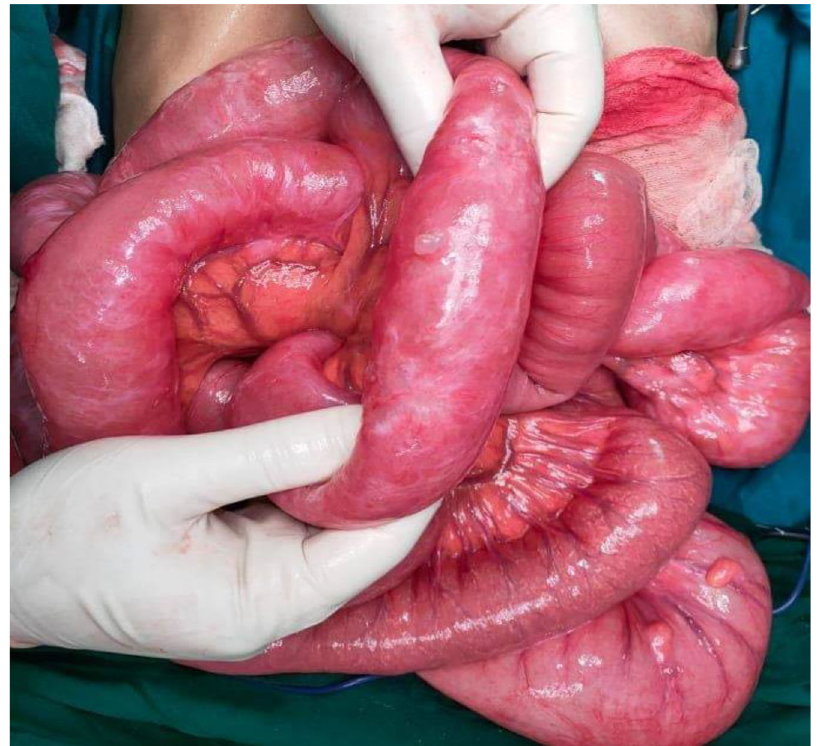
Figure 6. Ileal loop volvulus, involving a two-and-a-half clockwise turn around a long, pendulous small bowel mesentery.